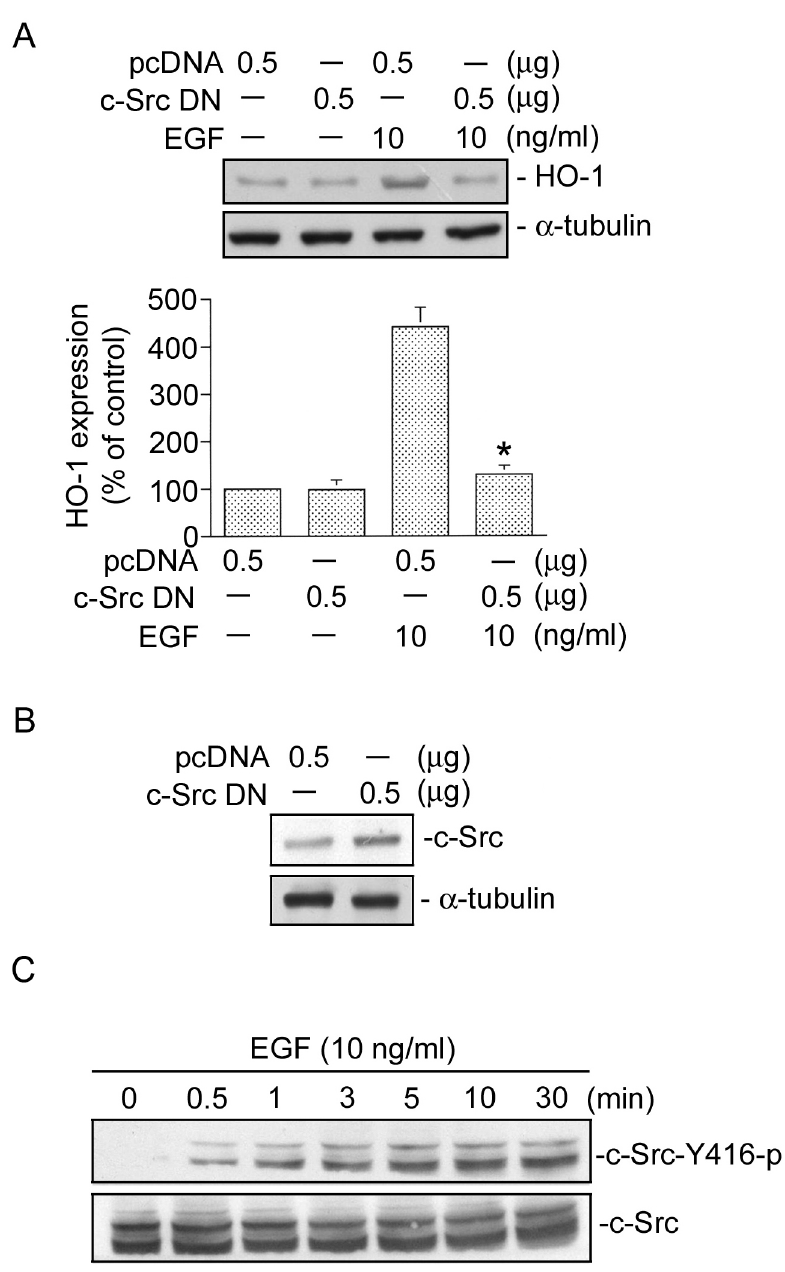
Figure 2. c-Src is involved in epidermal growth factor (EGF)-induced heme oxygenase (HO)-1 expression in HT-29 cells. A, HT-29 cells were transiently transfected with 0.5 m g of pcDNA or 0.5 m g of a dominant negative mutant of c-Src (c-Src DN) for 24 h. Cells were treated with EGF (10 ng/ml) for another 18 h. After incubation, HO-1 and a -tubulin protein levels were determined. Immunoblots are representative of three experiments, which are presented as the mean 6 SEM. *p , 0.05, compared to EGF treatment. B, Cells were transiently transfected with either 0.5 m g of pcDNA or 0.5 m g of c-Src DN for 24 h. Levels of c-Src or a -tubulin protein expressions were determined by a Western blot analysis. Traces represent results from three independent experiments. C, HT-29 cells were incubated with 10 ng/ml EGF for 0 , 30 min. Cell lysates were prepared, and c-Src Tyr416 phosphorylation was determined by immunoblotting using a phospho-c-Src Tyr416 antibody. Immunoblots are representative of three experiments with similar results. doi:10.1371/journal.pone.0104891.g002 expression, EGFR siRNA was used. As shown in Fig. 1E, (Fig. 1C). As previously mentioned, the EGFR is necessary for transfection with EGFR siRNA (25 nM) also completely inhibited EGF responses. To examine whether the EGFR is involved in EGF-induced HO-1 expression ( n = 3) (Fig. 1E). To confirm EGF-induced HO-1 expression, AG1478 was used. Figure 1D results of EGFR siRNA experiment, we also used EGFR siRNA to shows that pretreatment of HT-29 cells with AG4178 (10 m M) suppress EGFR protein expression in HT-29 cells. We found that completely inhibited EGF-induced HO-1 expression ( n = 3). To that EGFR siRNA markedly inhibited EGFR protein expression further confirm the role of the EGFR in EGF-induced HO-1